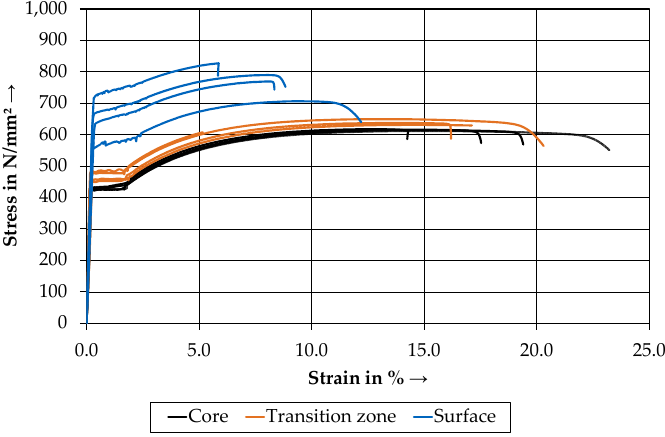
Figure 7. Results of the tensile tests in a stress–strain diagram for all microstructure specimens .